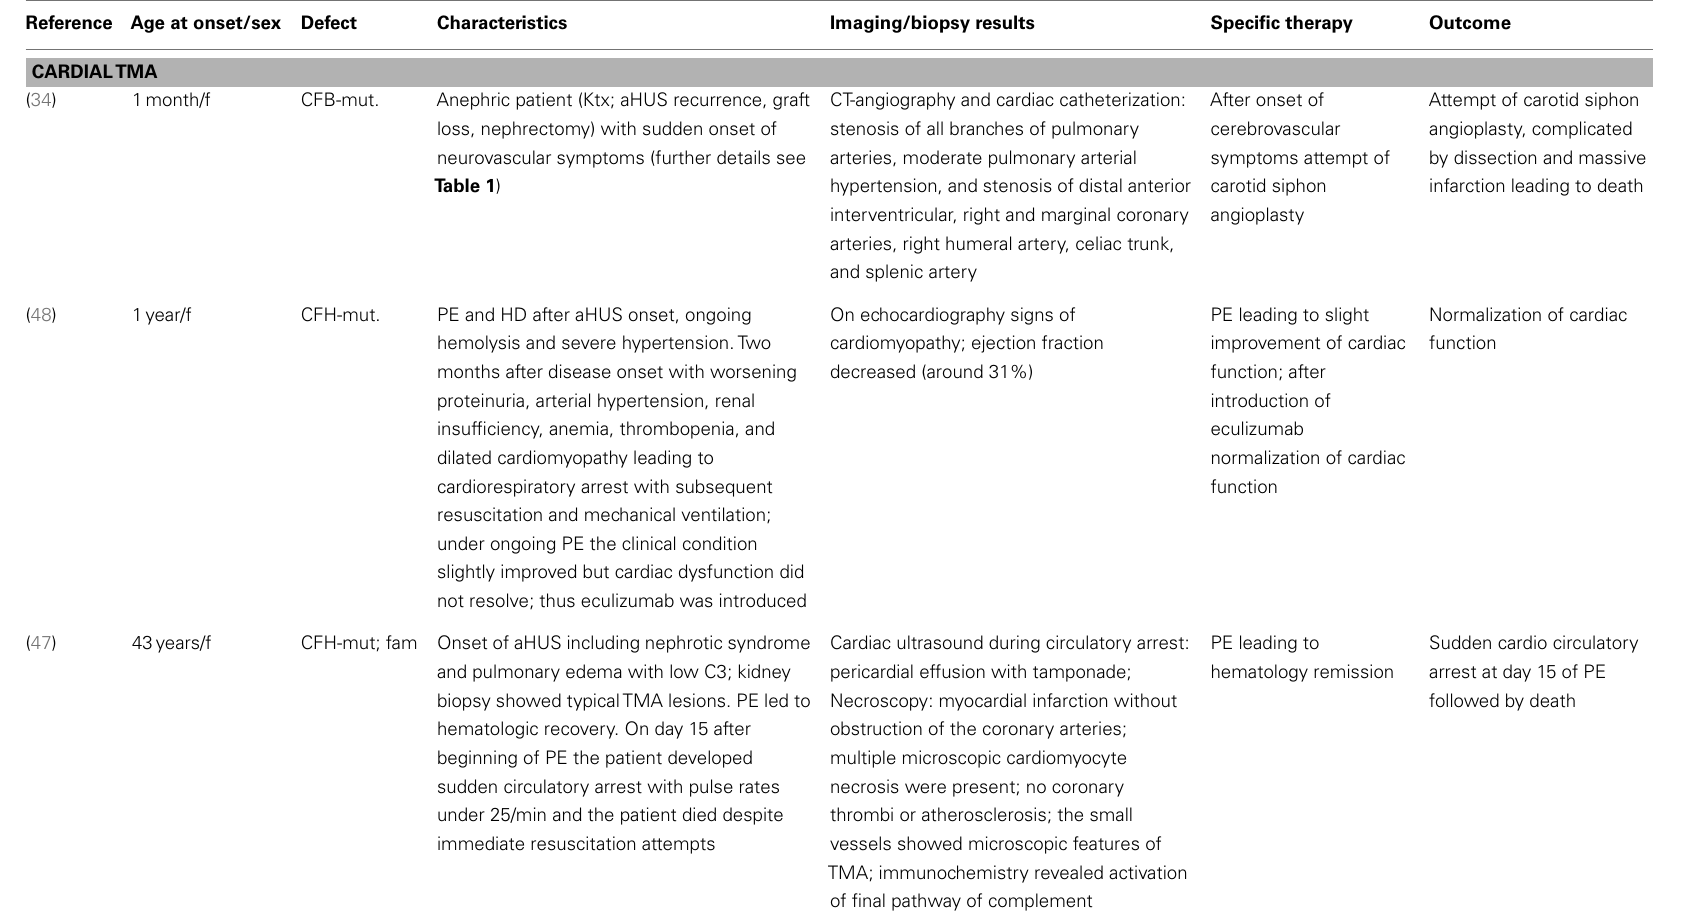
Table 2 | Overview of case reports on cardiovascularTMA manifestations in aHUS . Reference Age at onset/sex